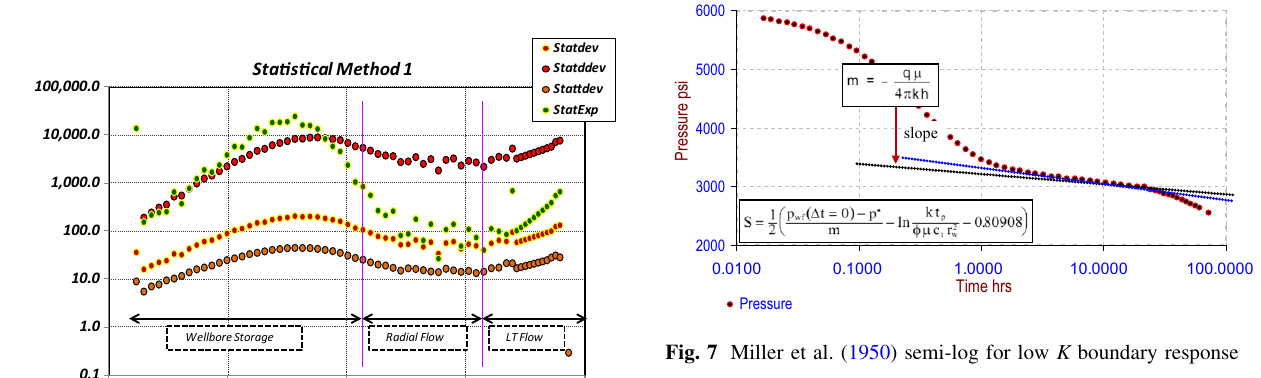
Fig. 5 StatSSE and StatDiv semi-log for low K boundary response